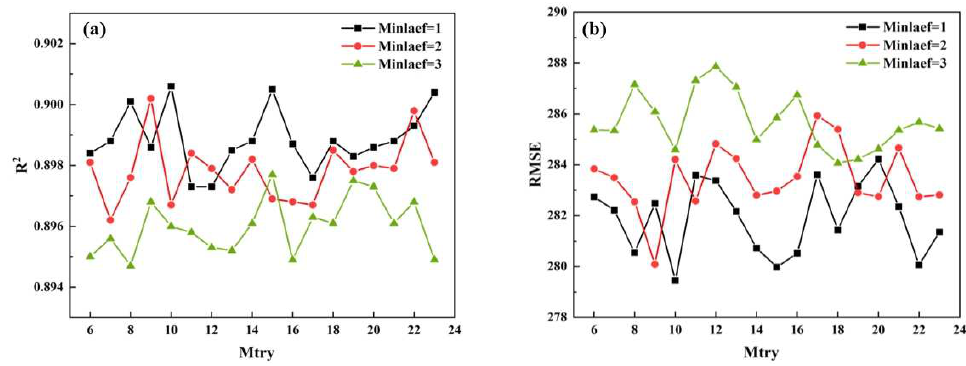
Figure 4. R 2 ( a ) and RMSE ( b ) for different combinations of Min leaf and M try. Models were built based on “optimal” parameters and training samples, and model training and validation were also performed (Figure 5). In the model training process, R 2 , RMSE, and bias for the model were 0.986, 109.039, ions cm − 3 , and 0.815 ions cm − 3 , respectively. In the validation process, R 2 = 0.878, RMSE = 258.617 ions cm − 3 , and bias = 14.973 ions cm − 3 , respectively. The efficiency of the model was evaluated for NAI > 4000 ions cm − 3 , and the R 2 and bias reached 0.68 and 321.90 respectively. These results proved an excellent model performance to be applied regionally.